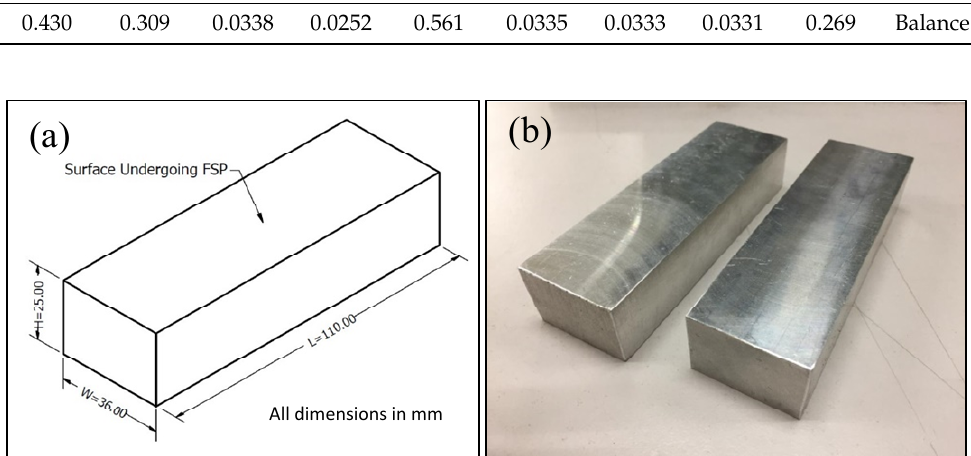
Figure 1. Recycled AA 6063 substrate, ( a ) schematic diagram and ( b ) actual substrate.